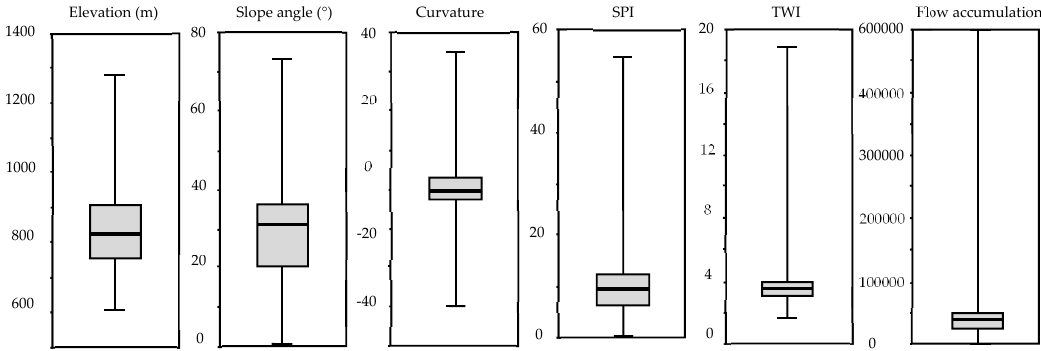
Figure 5. Boxplots showing the distribution of six influence factors in the study area: elevation, slope angle, curvature, SPI, TWI, and flow accumulation.